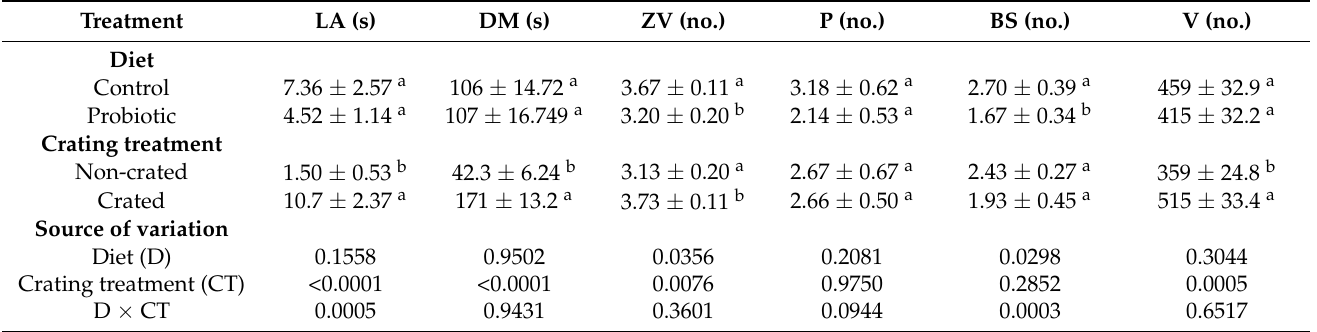
Table 6. Mean ( ± SEM) duration of latency to the first immobilisation (LA) (s), duration of mobility (DM) (s), number of zones visited (ZV), number of pecks directed to the floor or the walls (P), frequency of body shaking (BS), and number of vocalisation